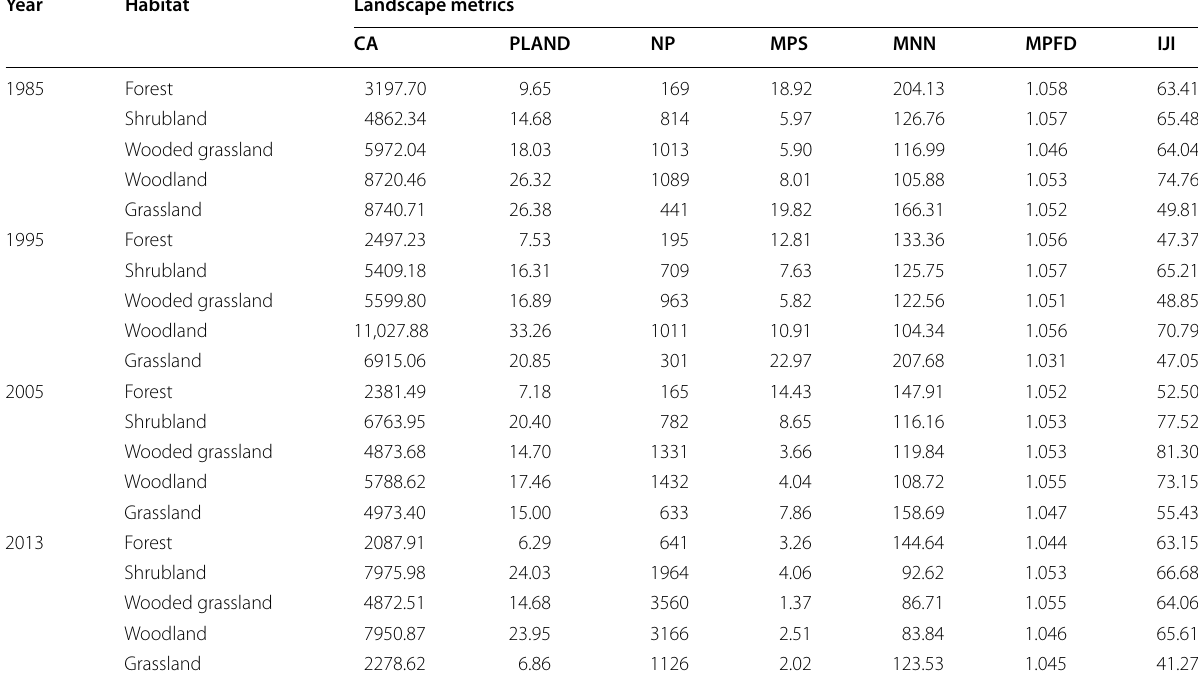
CA class area (ha), PLAND % of landscape, NP number of patches, MPS mean patch size (ha), MNN mean nearest-neighbor distance (m), IJI interspersion juxtaposition index (%), MPFD mean patch fractal